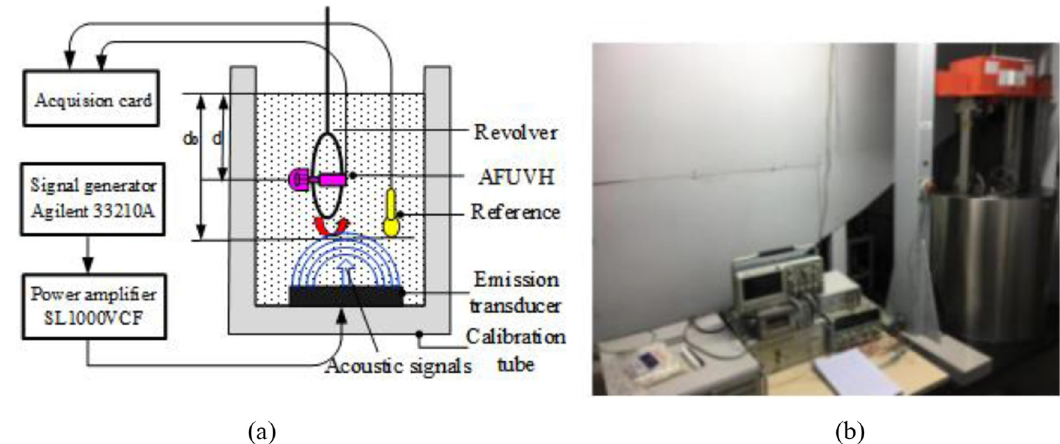
Fig. 18. Experimental test picture. (a) Schematic diagram of calibration system (b) Experimental testing environment.